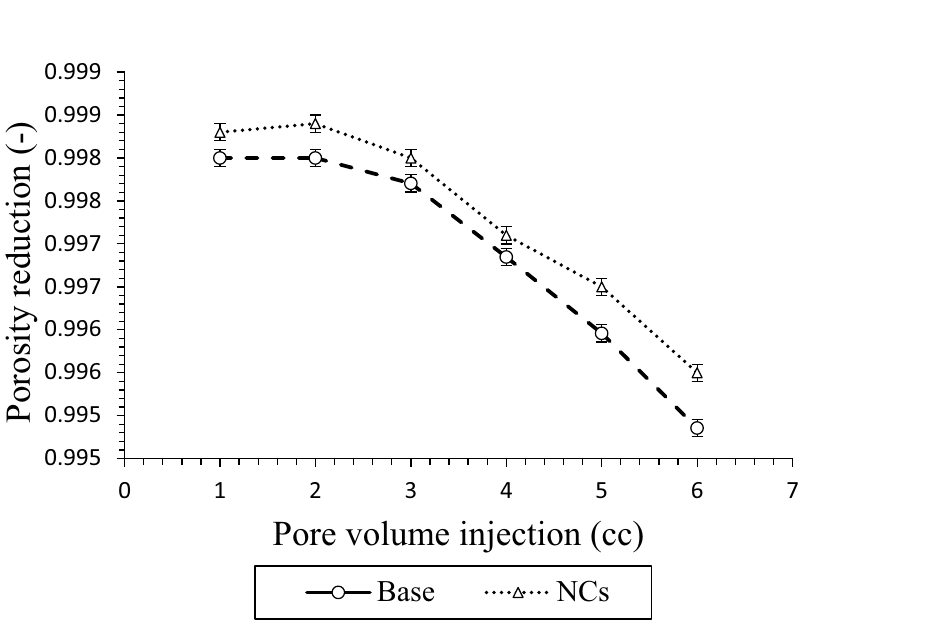
Figure 14. Porosity reduction in the presence of NCs during CO 2